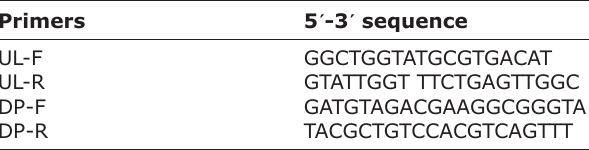
Table-2: Sequences of DP primers used for this research